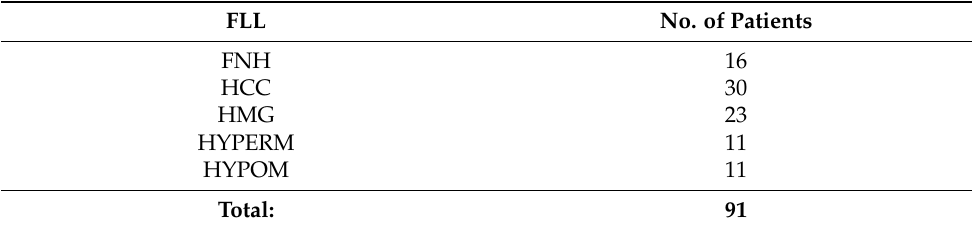
Table 1. Number of patients for different